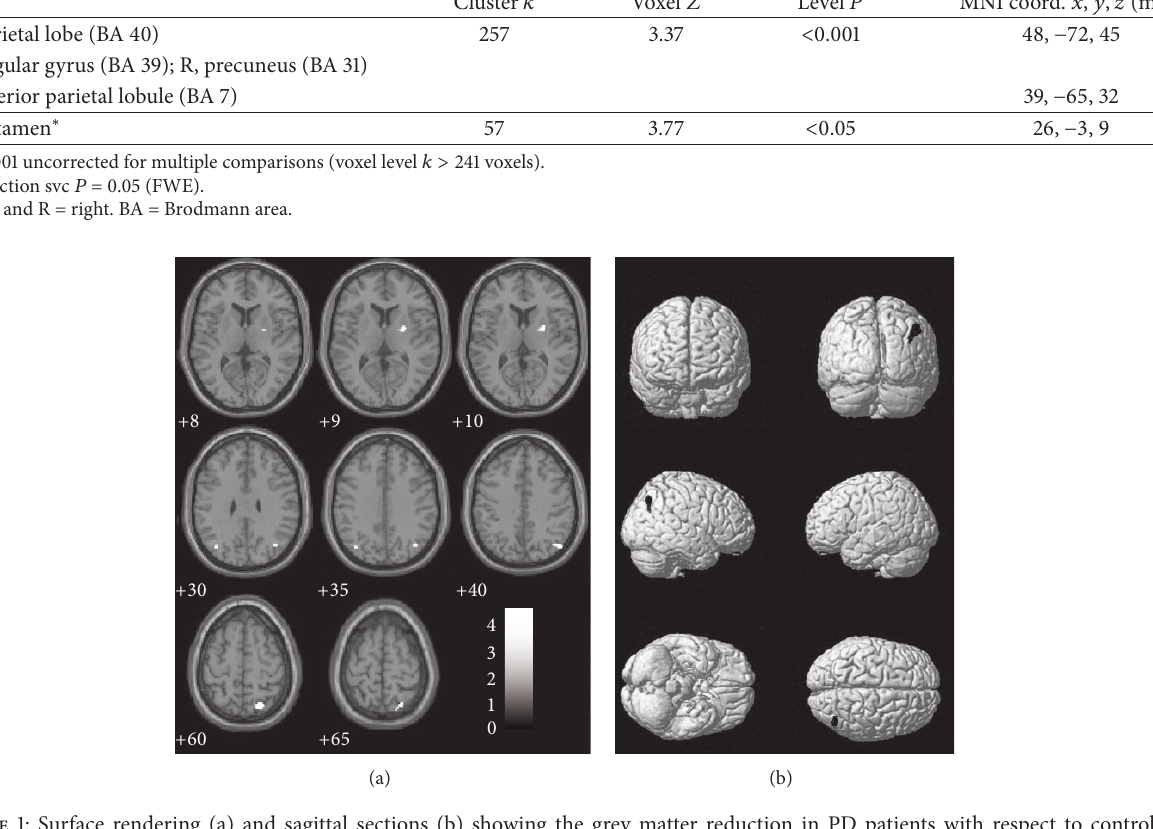
Figure 1: Surface rendering (a) and sagittal sections (b) showing the grey matter reduction in PD patients with respect to controls at baseline (test). Numbers below each sagittal slice represent the 𝑥 coordinate in MNI space. Clusters are superimposed on the MNI template implemented in SPM8 ( 𝑃 = 0.001 uncorrected; 𝑘 > 241